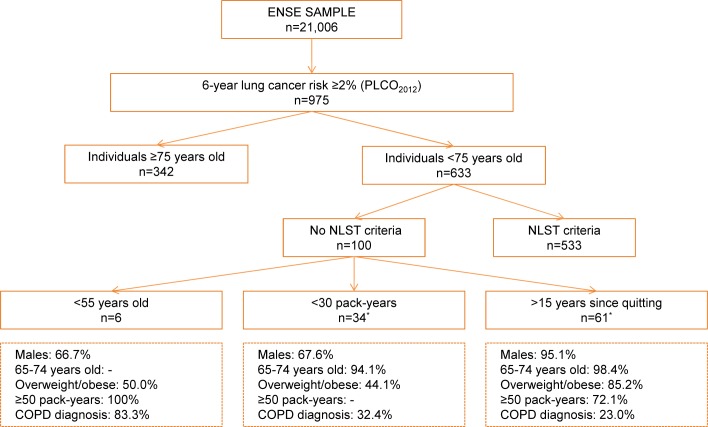
Distribution of ENSE participants with a 6-year lung cancer risk ≥2% who did not meet the NLST criteria.* One individual was a former smoker for more than 15 years and used to smoke <30 pack-years. Thus, the total sums up 101, not 100.